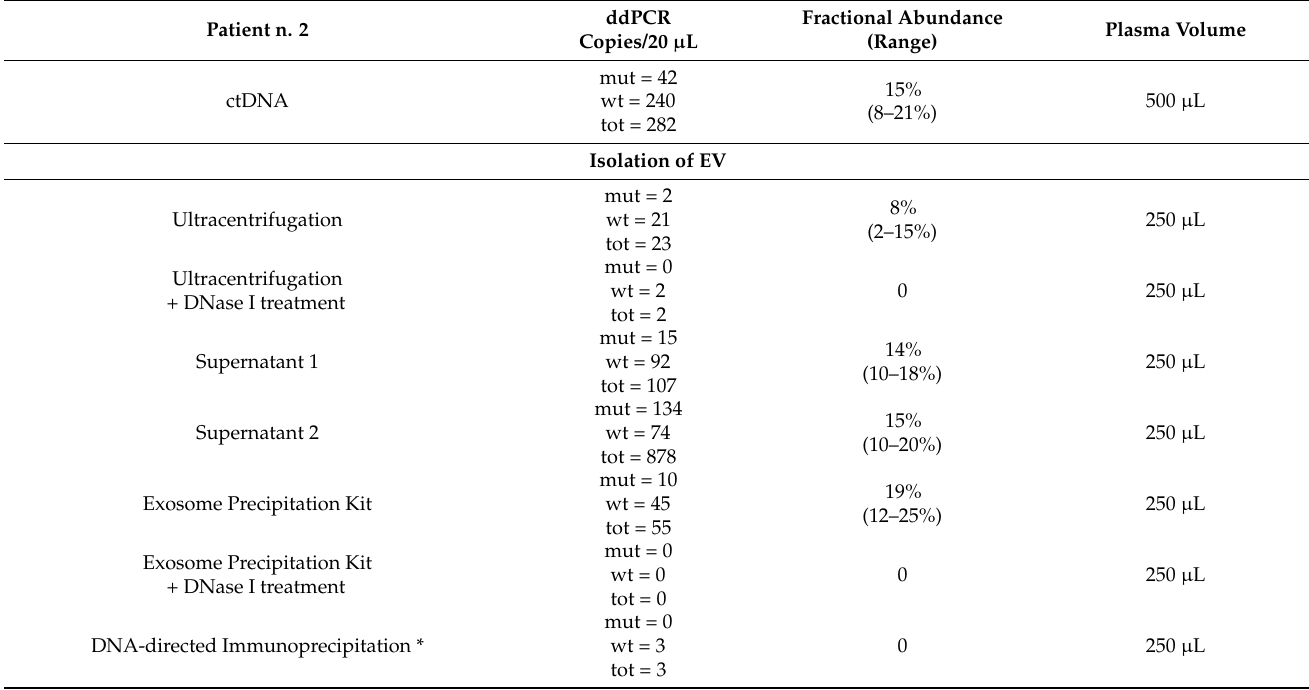
Figure 4. TEM images and histogram of the relative frequency of the EV diameters. Sample: ( a , b ) untreated sEVs; ( c , d ) sEVs subjected to thermal treatment; and ( e , f ) sEVs subjected to DNase I treatment. White arrows indicate isolated sEVs. The boxes represent enlarged sections of the images. Table 3. Results obtained by ddPCR analysis for the BRAF V600E mutation on ctDNA and sEVs associated DNA with and without DNase I